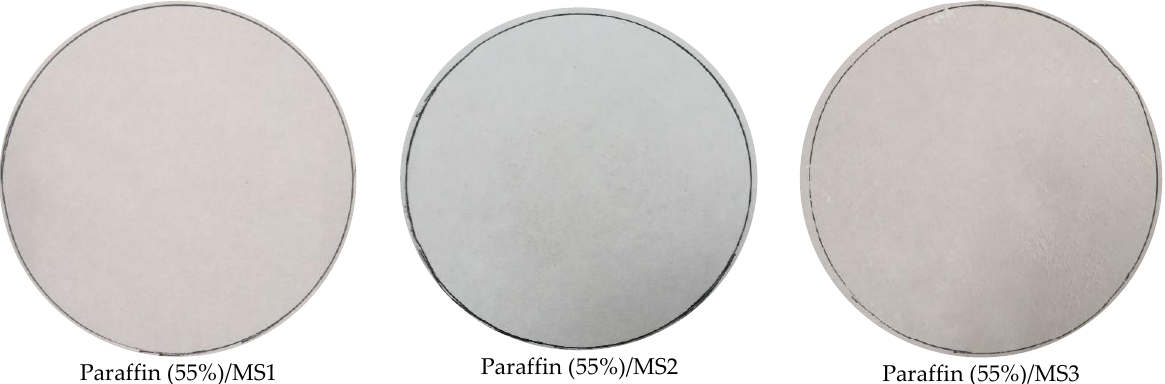
Figure 2. Leakage test of MS1, MS2 and MS3 SS-PCMs with different paraffin mass proportion after heating.